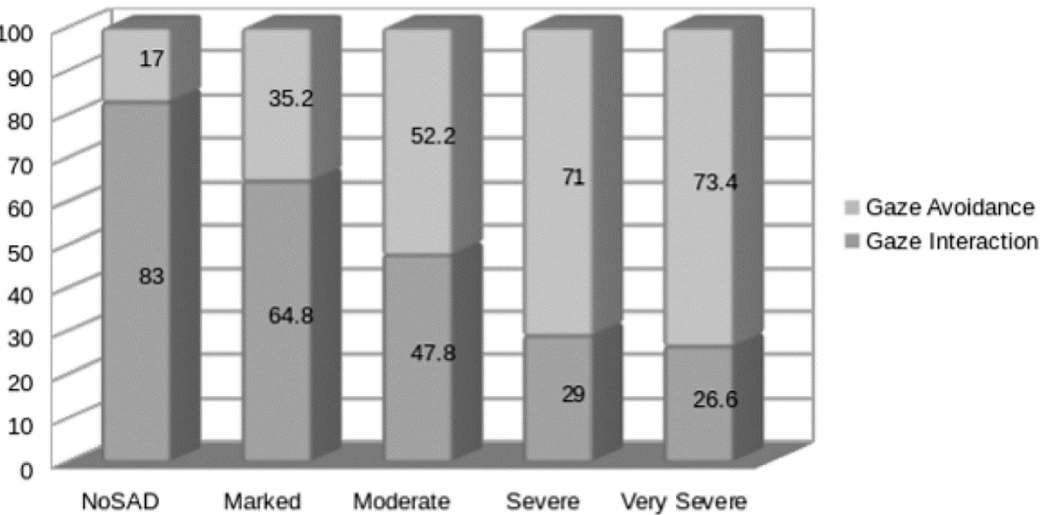
Figure 6. Overall view of gaze interaction and SAD relationship. Figure 6. Relationship between SAD and the gaze interaction of female